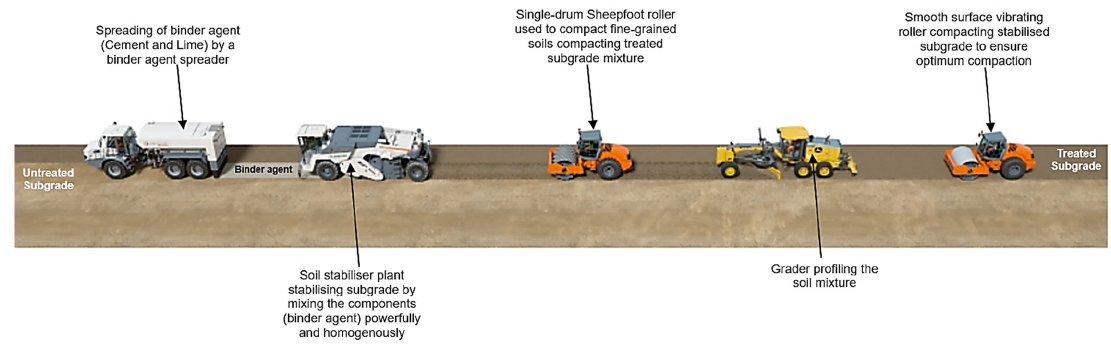
Figure 2. The application process of binder agent in real-life road construction. Table 1. Merits of in situ stabilised subgrade and demerits of subgrade removal and replacement [15] .